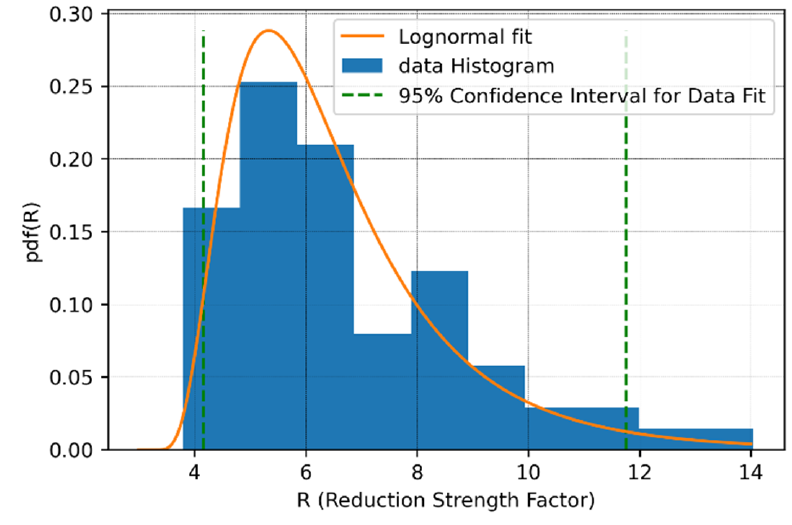
Figure 11. Statistical adjustment of the R factor.